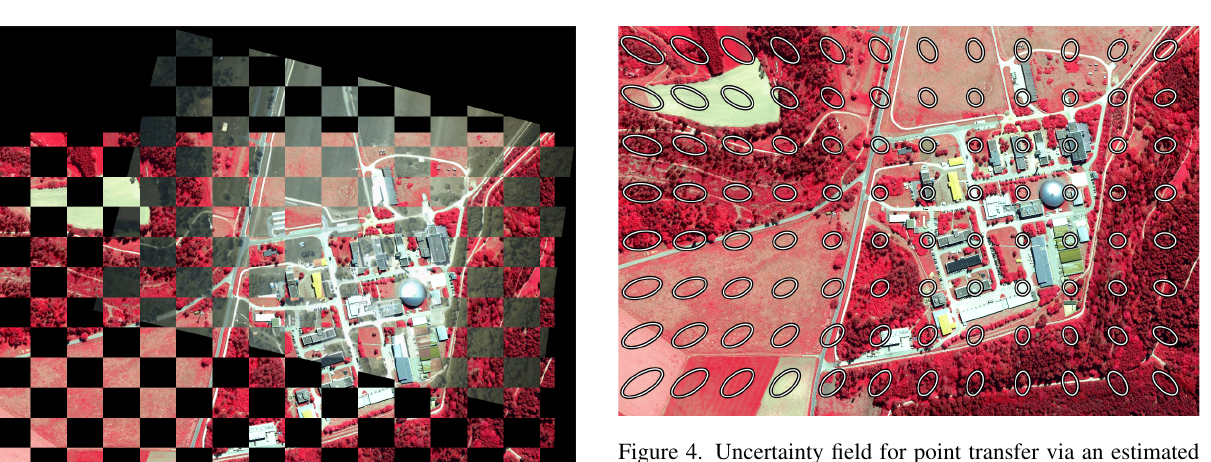
Figure 4. Uncertainty field for point transfer via an estimated homography. The standard ellipses enlarged by the factor 10 have been plotted for the point positions of a grid.